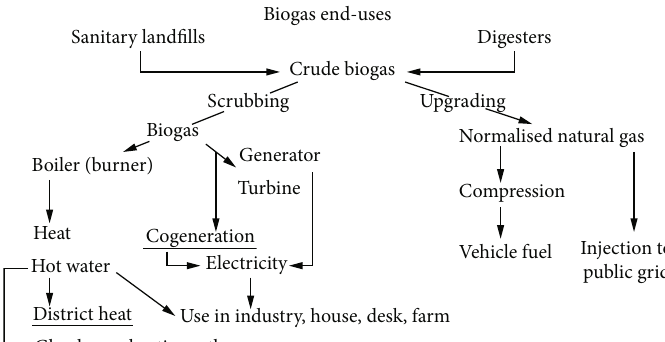
Figure 17: Summary of biogas applications in the energy